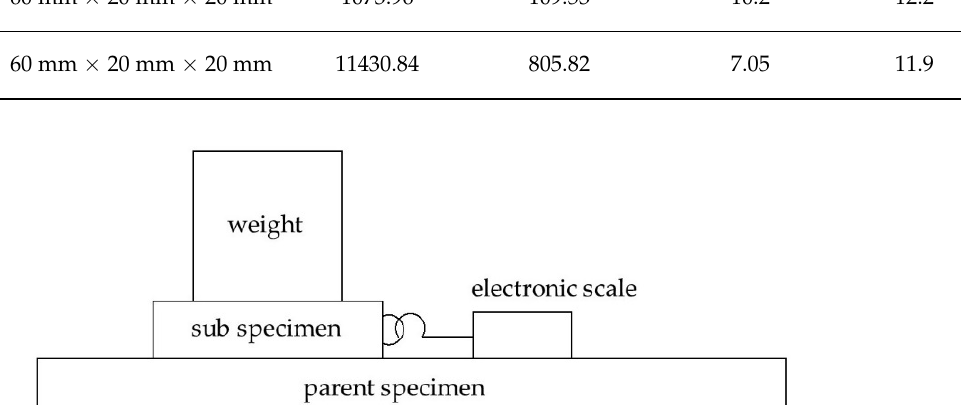
Figure 13. Loading diagram of the friction coefficient test. Note: the longitudinal grain direction of the parent specimen is horizontal; the longitudinal grain direction of the sub-specimen is vertical.